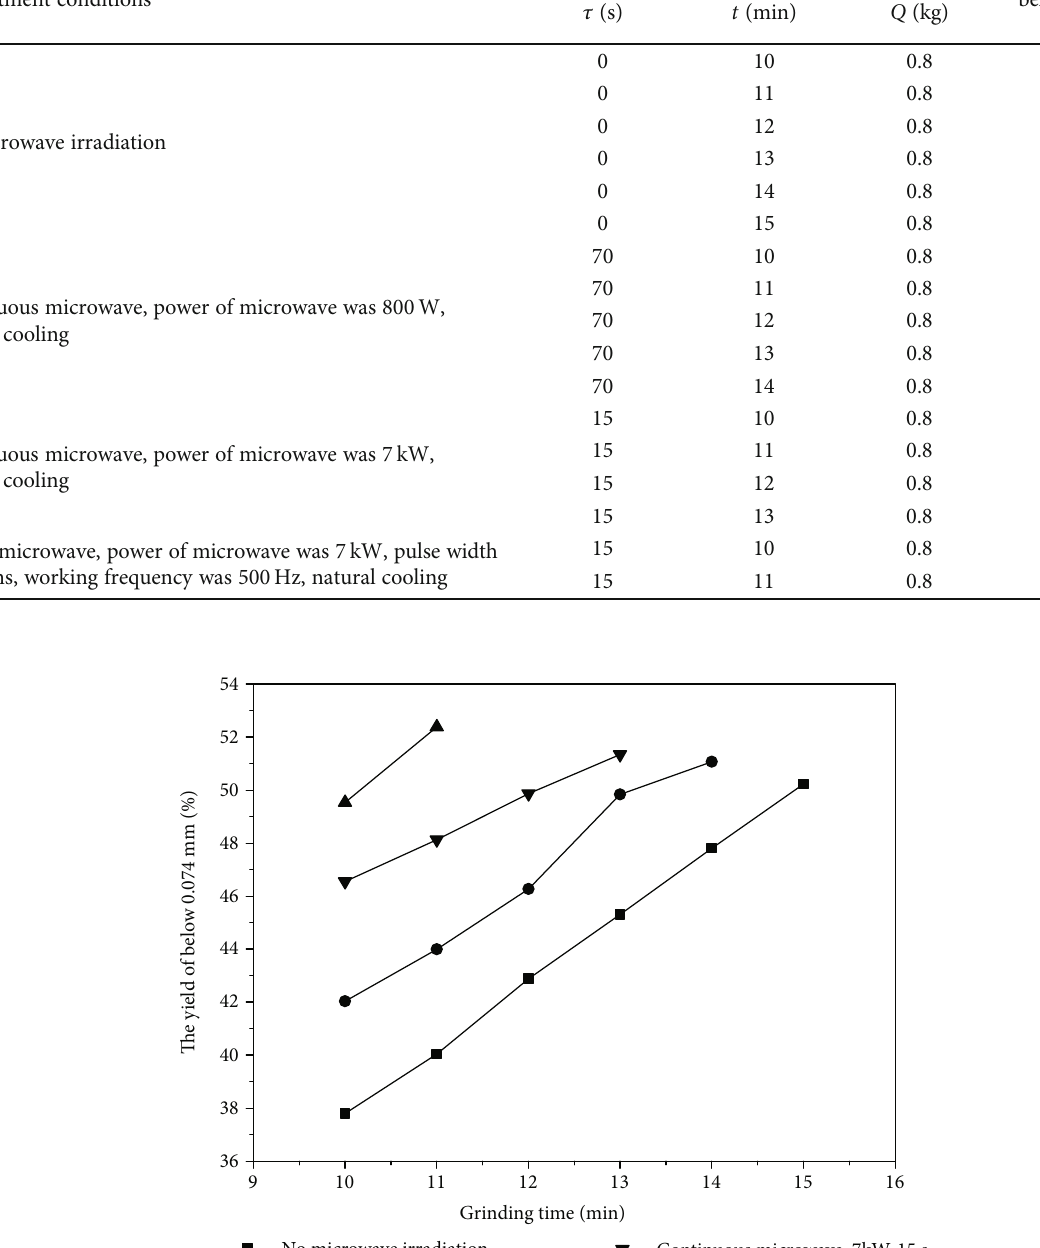
Table 3: Grinding fi neness of lead-zinc ore with di ff erent grinding time under di ff erent microwave pretreatment conditions. Pretreatment conditions